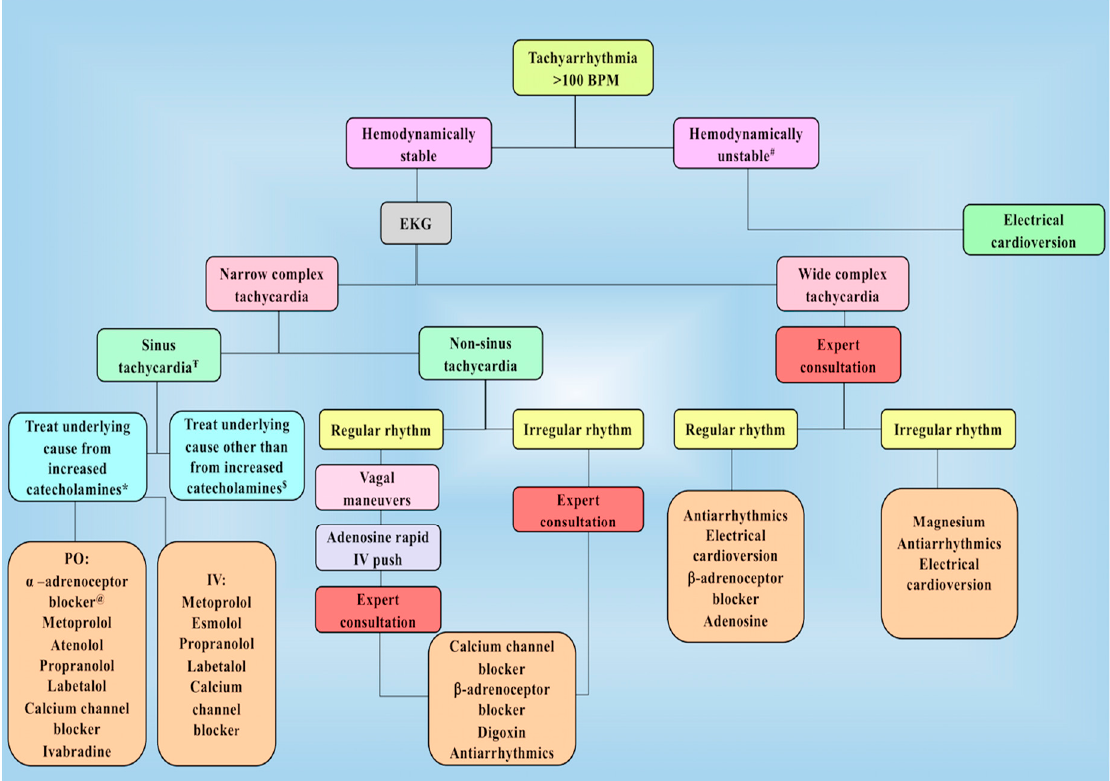
Figure 3. Management of tachyarrhythmia following PPGL resection in the postoperative period.